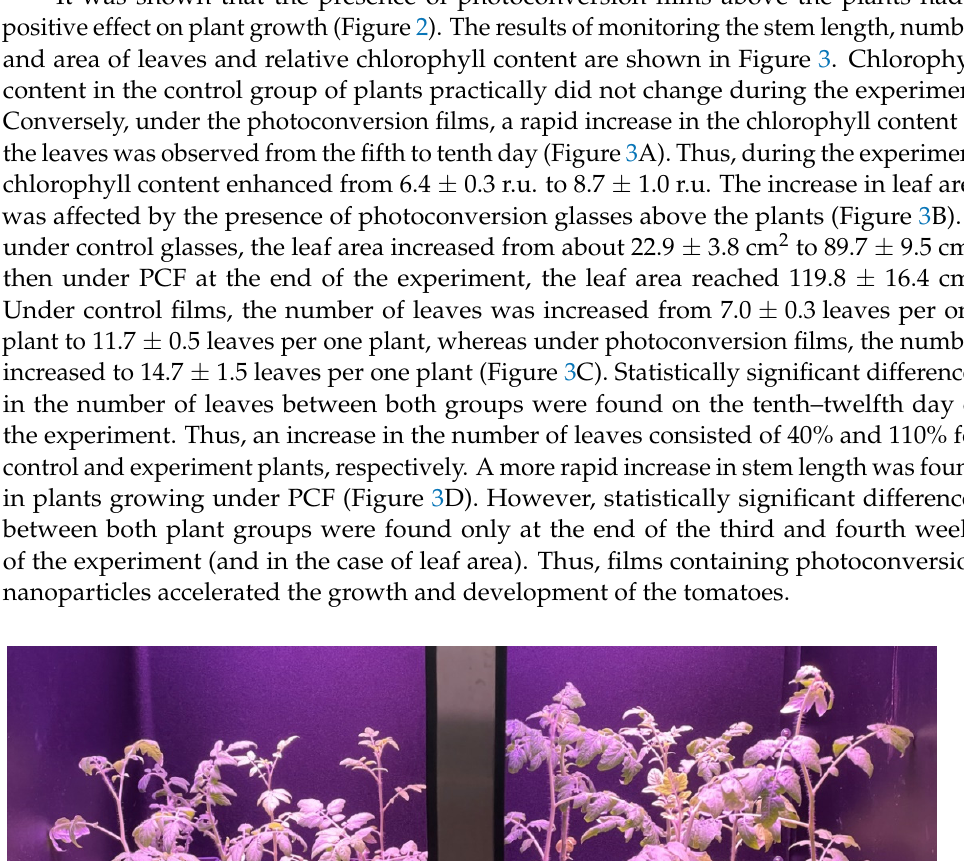
Figure 3. Dependence of relative chlorophyll content ( A ), total area ( B ) and number ( C ) of leaves and stem length ( D ) on grow time of plants under glasses coated with fluoroplate polymer without (1) or with (2) photoconversion nanoparticles. The data are the means of at least 11 measurements, with the standard error of the mean. Relative chlorophyll content value is the mean of 4–10 measurements on at least 11 plants. To explain this, we have performed an analysis of the light-induced changes in the ChlF (Figure 4). The maximum quantum yield ( Δ F/F m ) in the leaves of dark-adapted plants before the experiment was equal to 0.82 and practically did not change within the experiment (Figure 4A). It is known that light energy absorbed by the photosynthetic antenna can distribute between three processes capable of utilizing the excitation energy. These processes are reflected in quenching the chlorophyll fluorescence: so-called